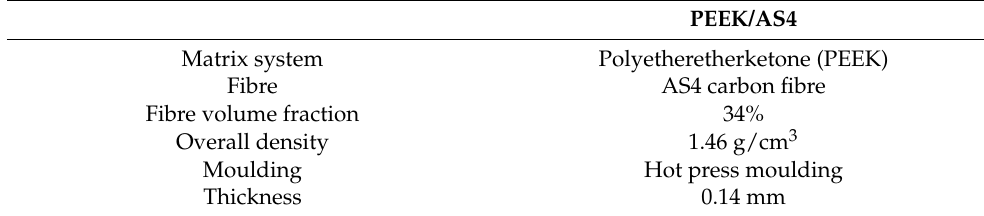
Table 1. The properties of the PEEK/AS4 prepreg.